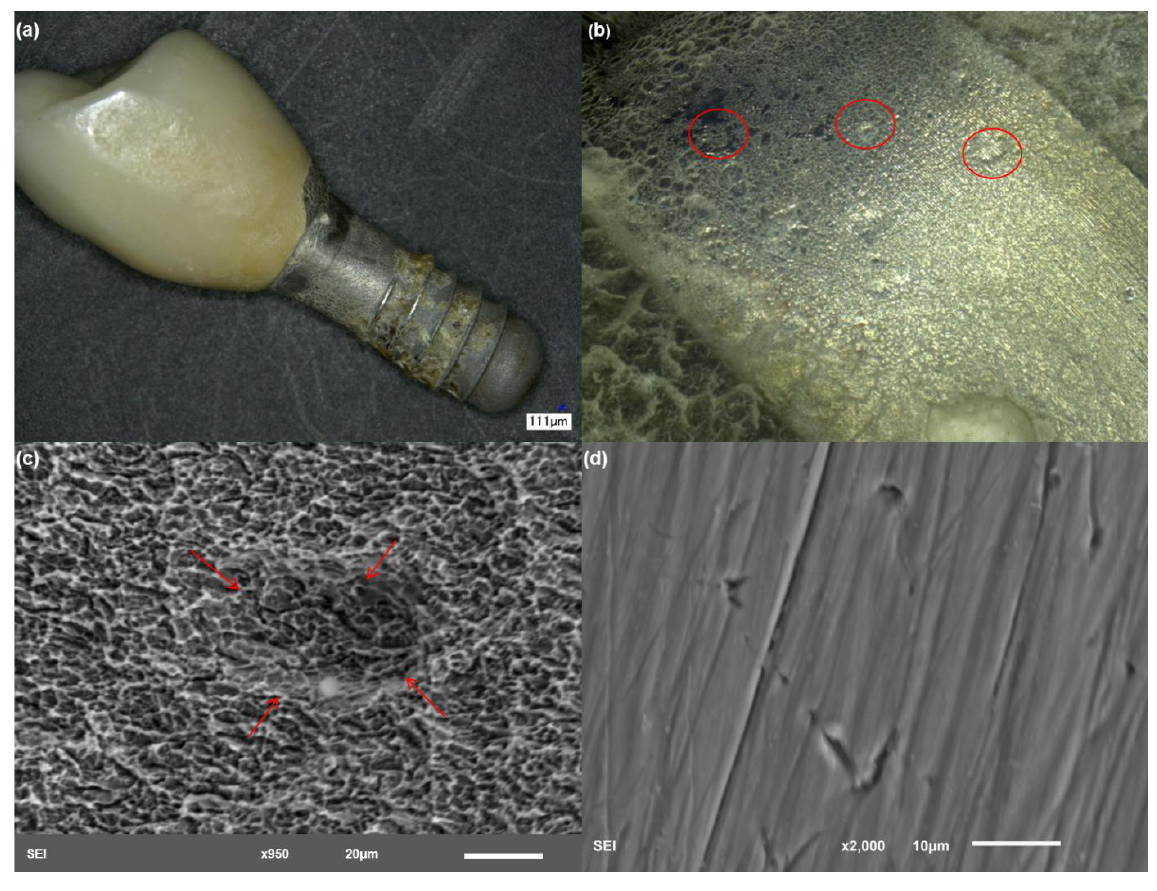
Figure 6. Structure of implant 5. ( a ) Low magnification showing the gross features of the implant with bone attachment throughout the surface of the implant and cement surrounding the crown edges; ( b ) discoloration is also evident in this example; the smooth surface was covered by cement; ( c ) implant rough interface with evidence of crack development. The arrows highlight a large pit with crack nucleation inside; and ( d ) higher magnification of an exposed area of the abutment with